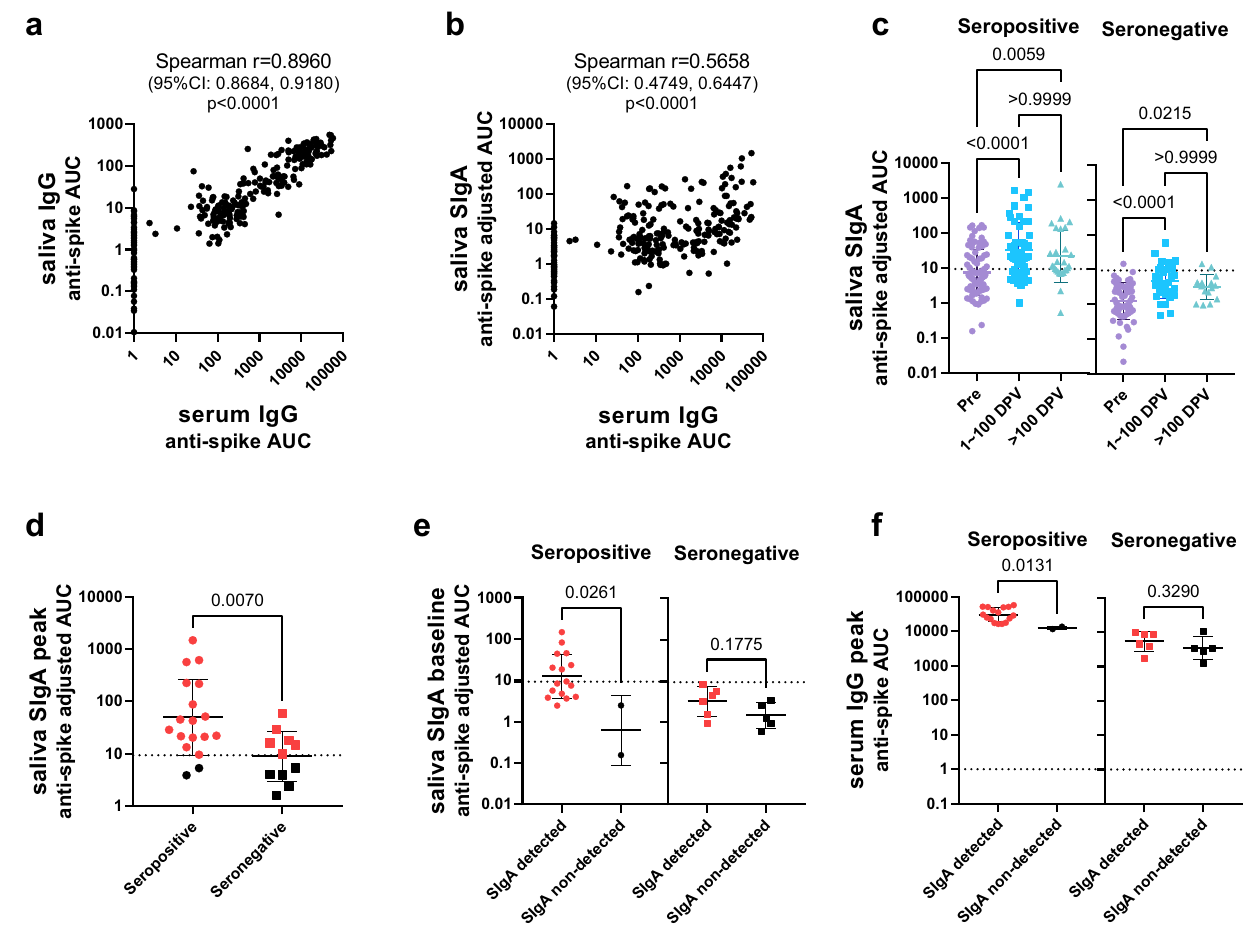
Fig. 2 | Mucosal SIgA antibody response to vaccination in adult participants with or without previous SARS-CoV-2 infection. a , b Correlation between anti- spike serum IgG antibody titers and saliva IgG antibody titers ( a ) or mucosal SIgA antibody titers ( b ) of samples collected from both seropositive and seronegative individuals at all time points. A total of 264 data points (6 – 13 data points per individual) were plotted for each panel. X and Y -axis values represent antibody titers (AUC: area under the curve). Spearman correlation coef fi cient and p values (two-tailed)arelabeledabovegraphs. c Comparisonofanti-SARS-CoV-2spikeSIgA titers in saliva between samples collected during different timepoints: before fi rst vaccination (Pre, 91 samples in seropositive group and 62 samples in seronegative group), 1 – 100 days post fi rst vaccination (1 – 100 DPV, 50 samples in seropositive group and 32 samples in seronegative group), and over 100 days post fi rst vacci- nation(>100DPV,28samplesinseropositivegroupand16samplesinseronegative group). Antibody titers (adjusted AUC) are plotted for each group. (statistical test: one-way ANOVA with Kruskal – Wallis test, p values above brackets). d Com- parison of peak anti-SARS-CoV-2 spike mucosal SIgA titers between seropositive